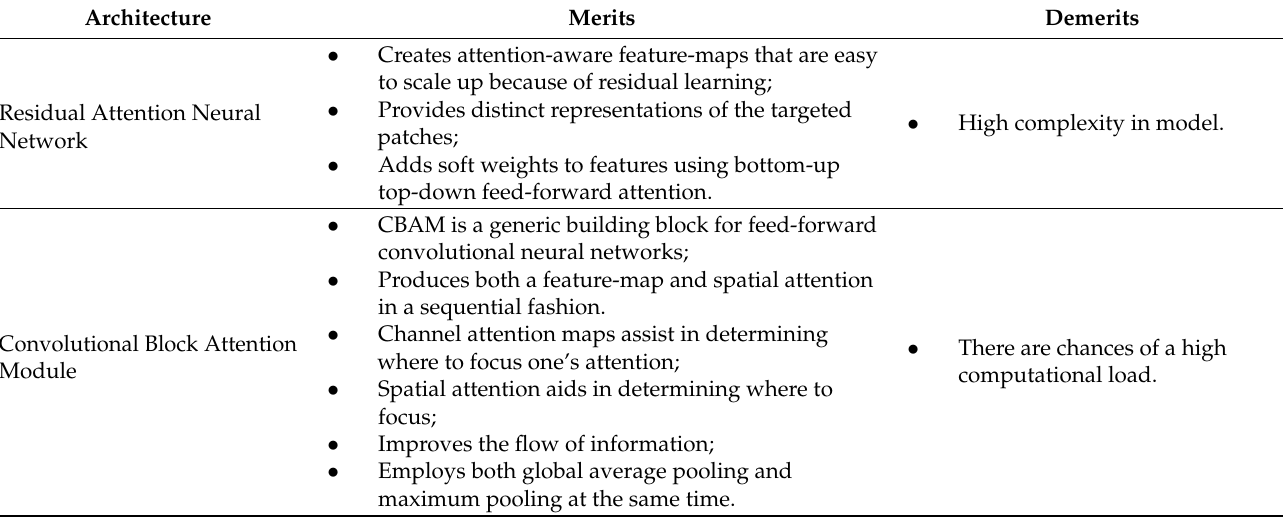
Table 8. Major issues linked with the deployment of attention-based CNN architectures.